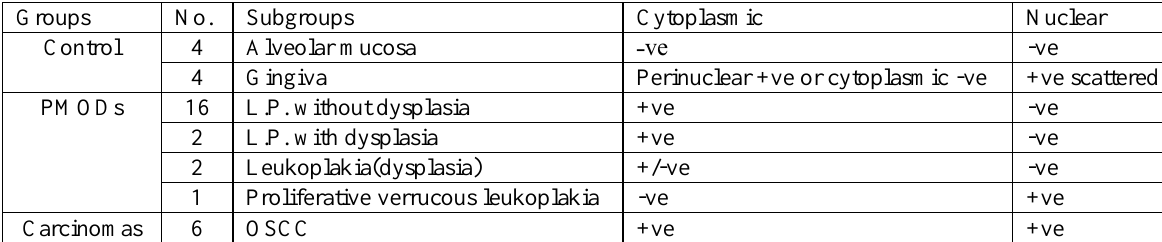
Table (5): Wnt3 expression and distribution in all